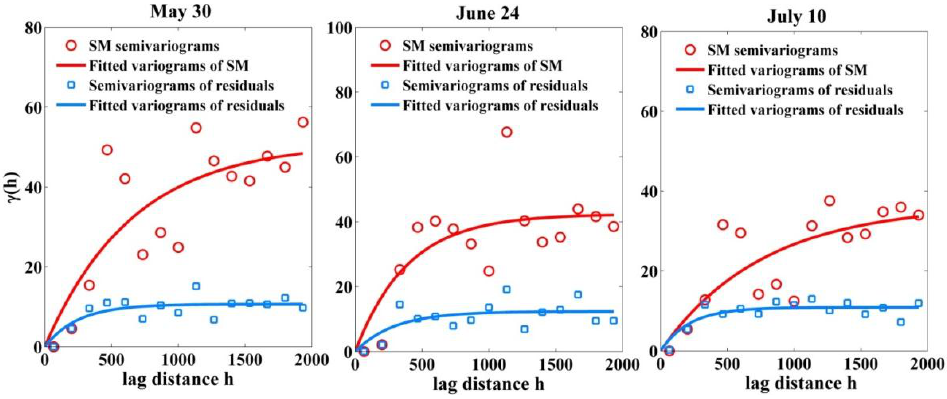
Figure 7. SM semi-variograms (red circles), the correspondingly fitted SM variograms (red solid line), the semi-variograms of SM residual (blue squares) and the correspondingly fitted residual variograms (blue solid